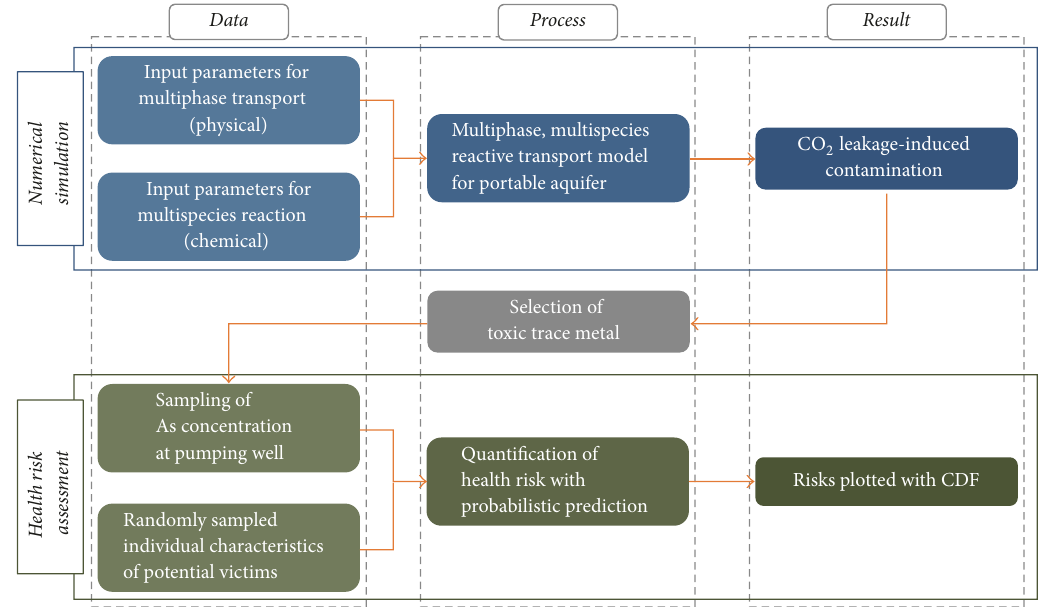
Figure 2: Flow chart explaining the sequence of both numerical simulation and probabilistic health risk assessment. Numerical simulation composed of multiphase and multispecies reactive transport modeling required both physical and chemical parameters within the shallow aquifer. Subsequently, the output of numerical simulation was utilized for calculating probabilistic health risk for carcinogenic effect.